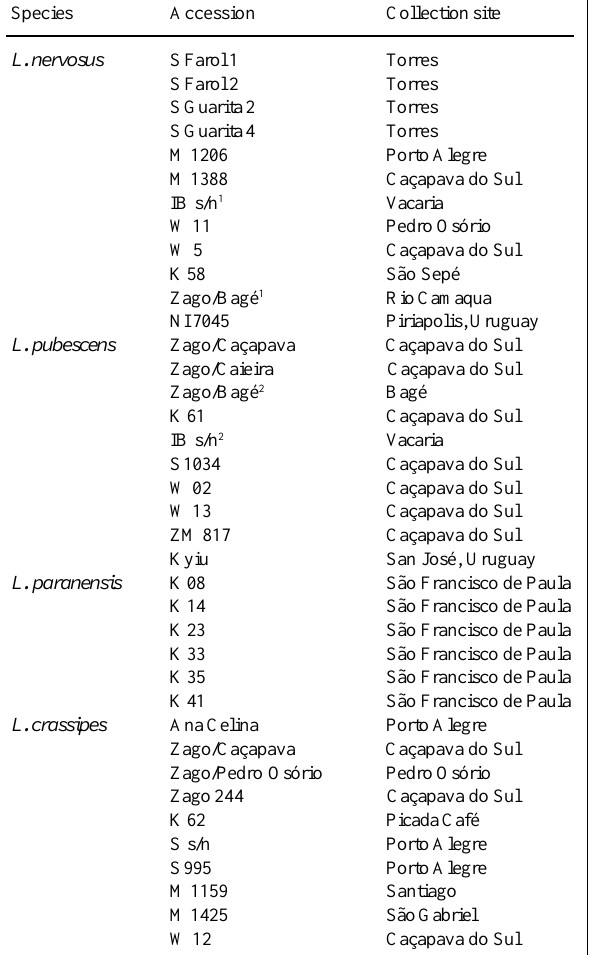
Table I - Lathyrus accessions examined in Rio Grande do Sul State.